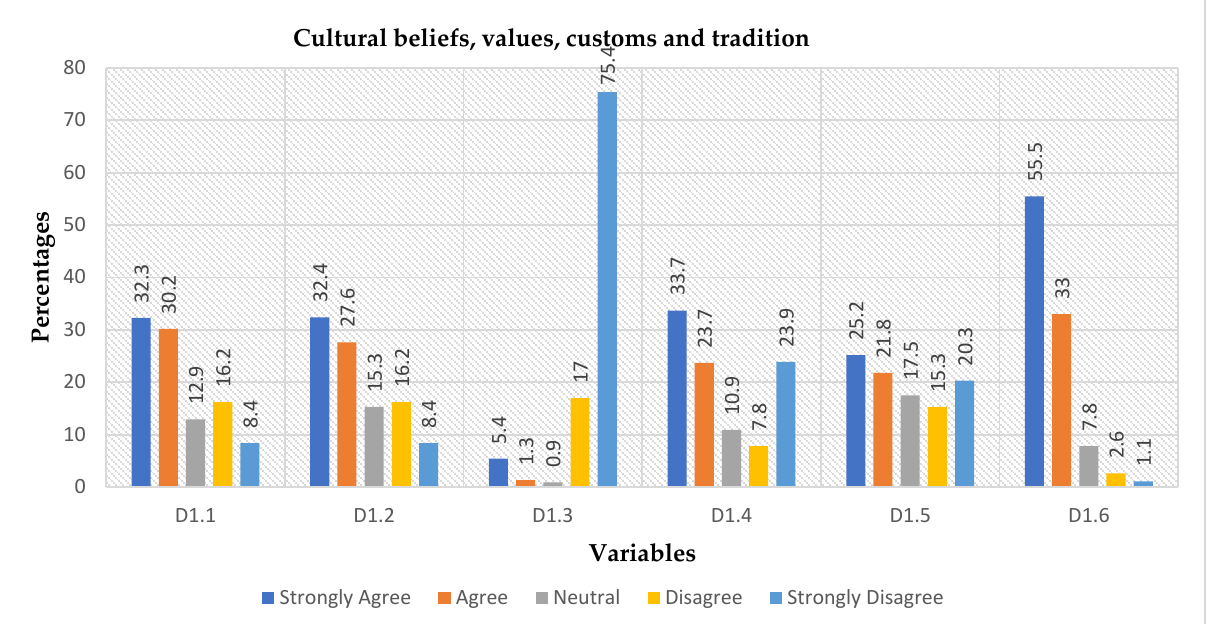
Figure 2. The illustration of how respondents incorporate their beliefs, values, practices, natural resources, mores, customs, rituals, and tradition to indigenous way of managing waste. Variables are questions: D1.1 = Cultural beliefs, D1.2 = Cultural values, D1.3 = Waste on the ground, D1.4 = Natural resources, D1.5 = Cultural mores, D1.6 = Customs, rituals, and tradition.